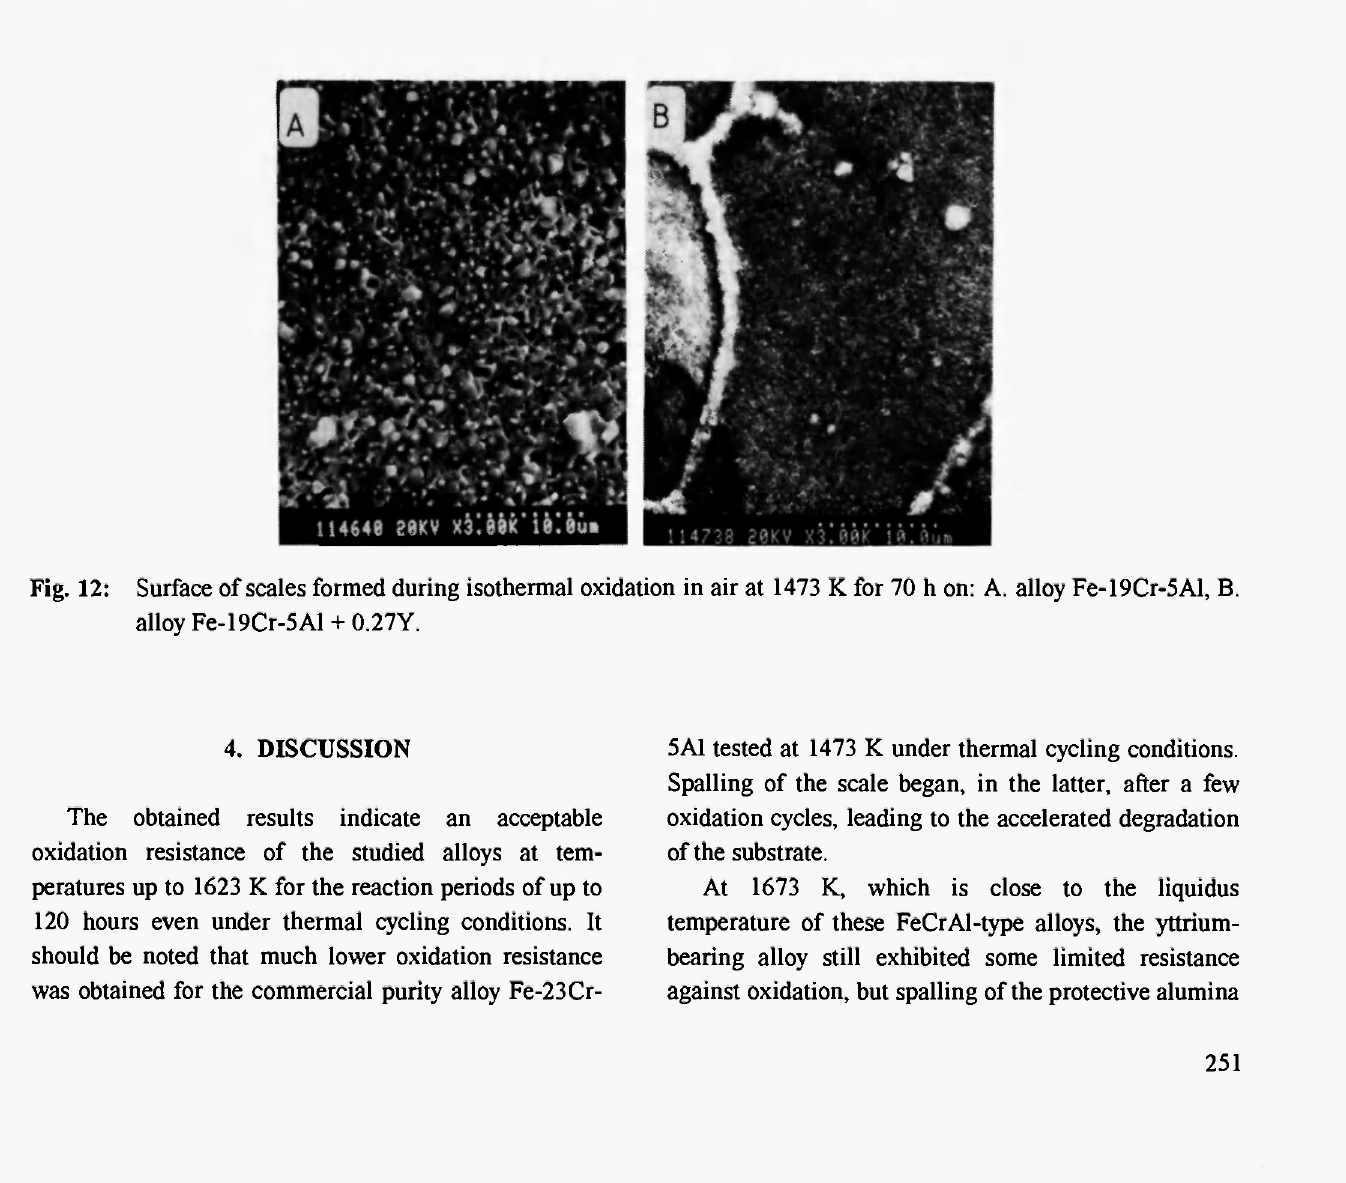
5A1 tested at 1473 Κ under thermal cycling